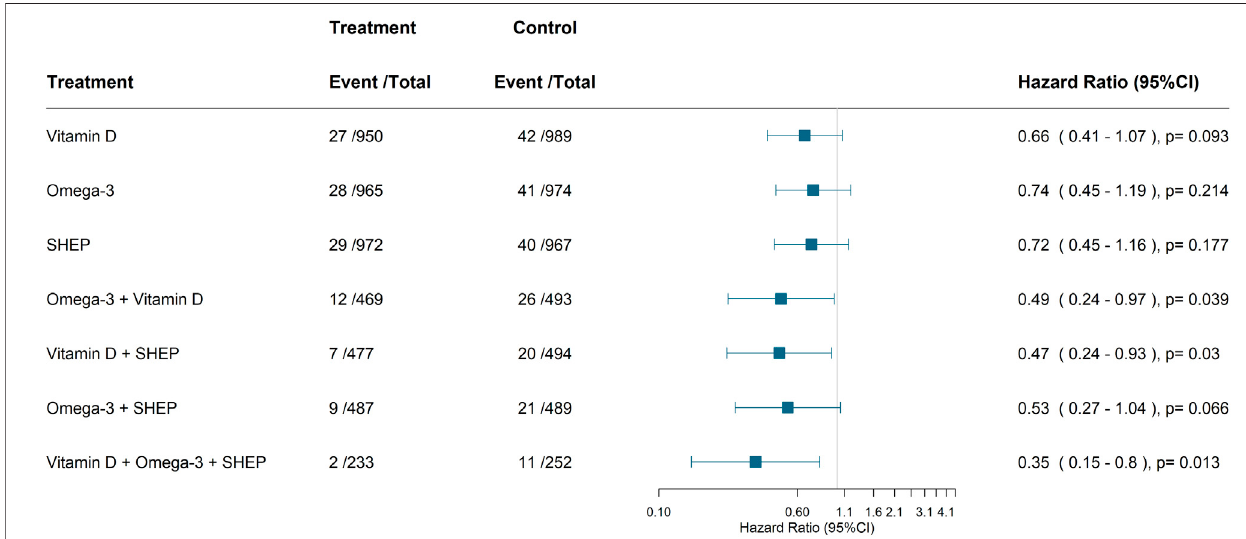
FIGURE3| Primaryendpoint — sensitivityAnalysis — excludingparticipantswithahistoryofcancer.Cox-proportionalhazardmodeladjustedforsex,BMI,priorfall, age,andstudycenter.Thecomparisongroupisalwaysthegroupthatdoesnothavetherespectivetreatment(s)ofinterested.Forallthreetreatments,itisthegroupwho